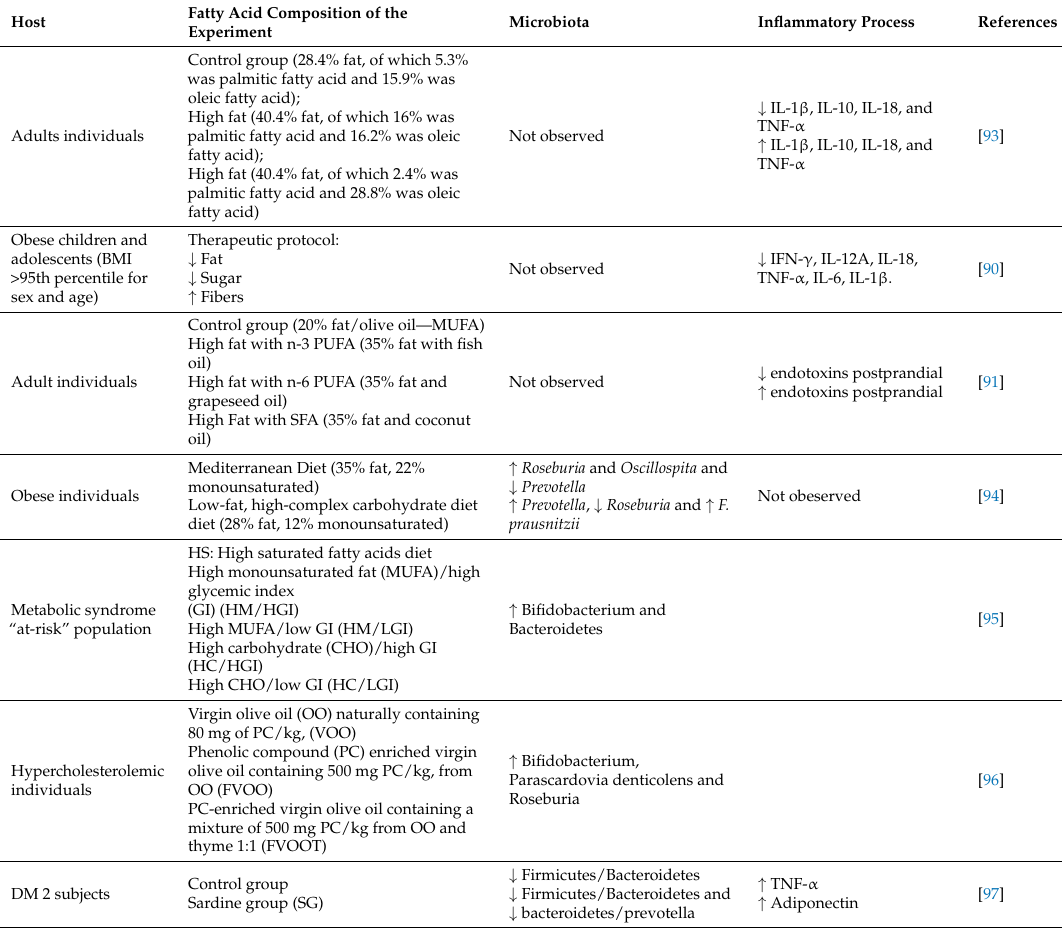
Table 5. Effects of different types of fatty acids on the inflammatory process and intestinal microbiota in human